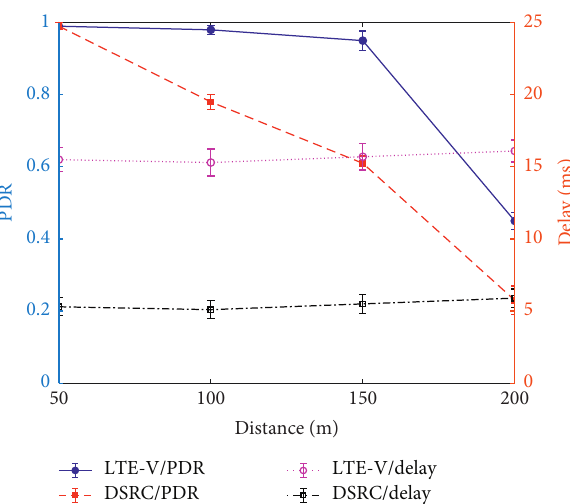
Figure 13: The results of performance in the forest-shielding scenario.